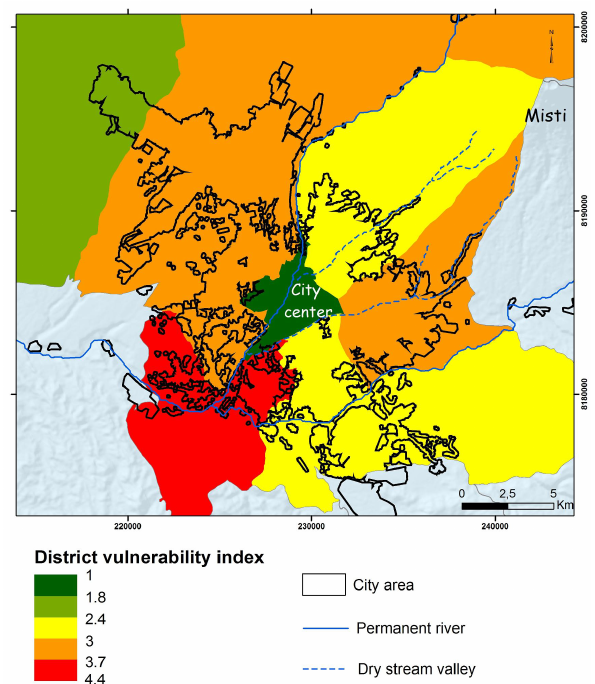
Fig. 9. Map of the socio-economic vulnerability in Arequipa. Socio- economic vulnerability index (SEvI) comprises five classes (see Ta- ble 5). Due to the scale of original data (city district), this map is less precise than the others maps obtained from this